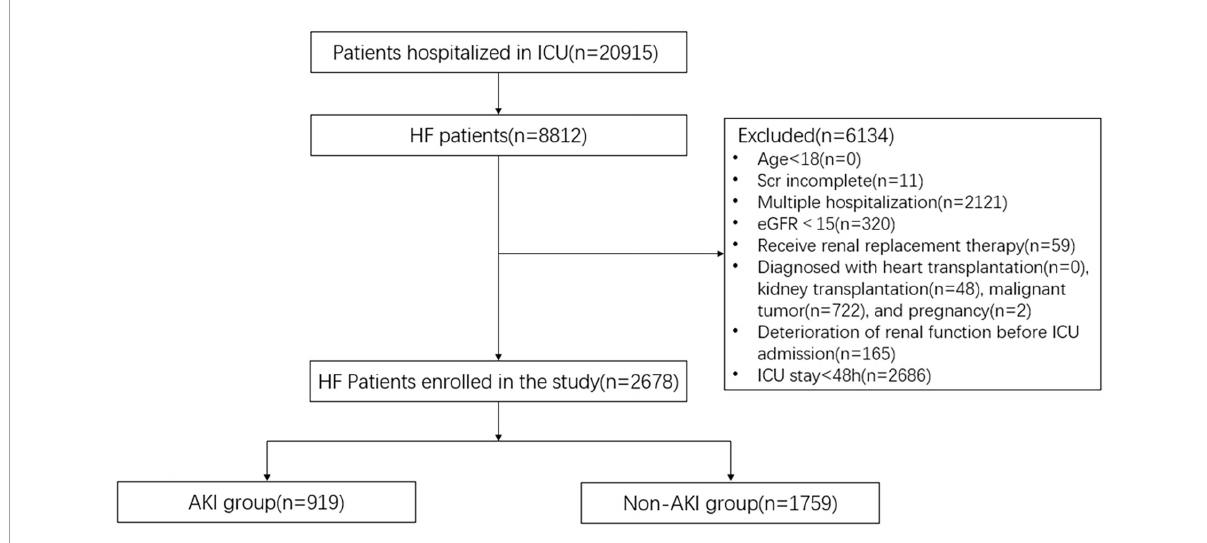
FIGURE2 Consort flow chart. A total of 2,678 patients were selected from the database with 20,915 patients. ICU, intensive care unit; HF, heart failure; Scr, serum creatinine; eGFR, estimated glomerular filtration rate; AKI, acute kidney